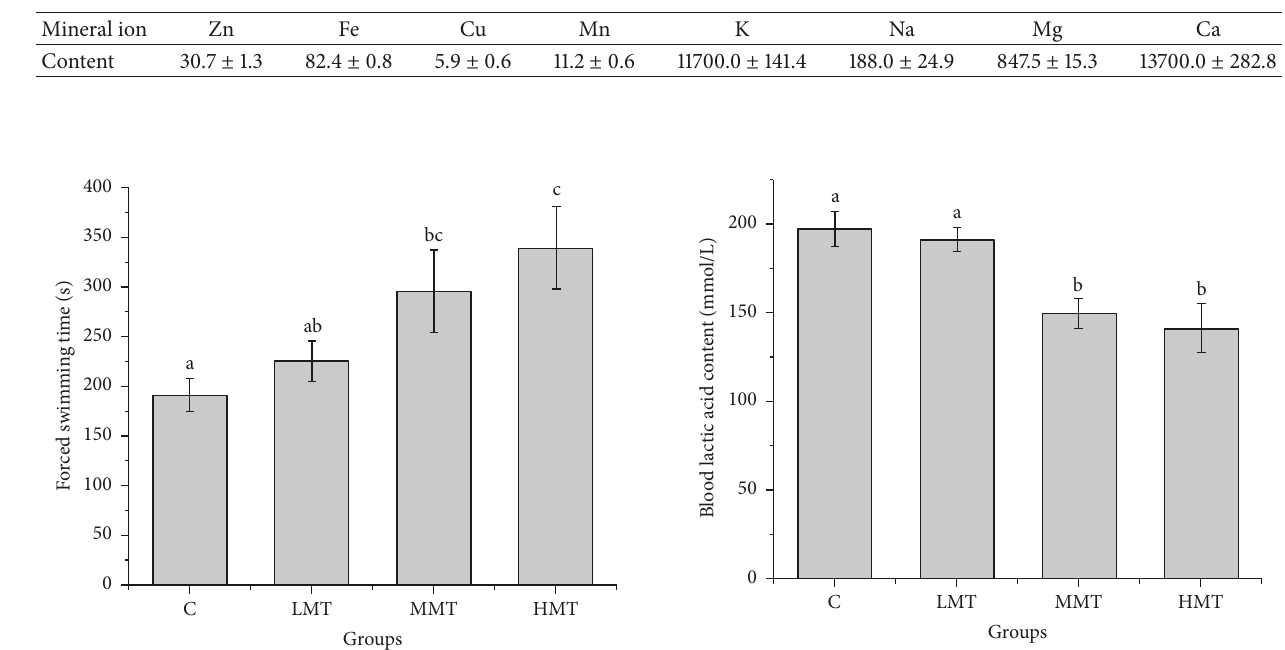
Figure 1: Effect of Xinjiang maca on forced swimming time (C, control; LMT, low-dose maca-treated group; MMT, medium-dose maca-treated group; HMT, high-dose maca-treated group. Each value represents the mean ± SD ( 𝑛 = 10 ). Different letters indicate significant differences among groups ( 𝑃 < 0.05 )).